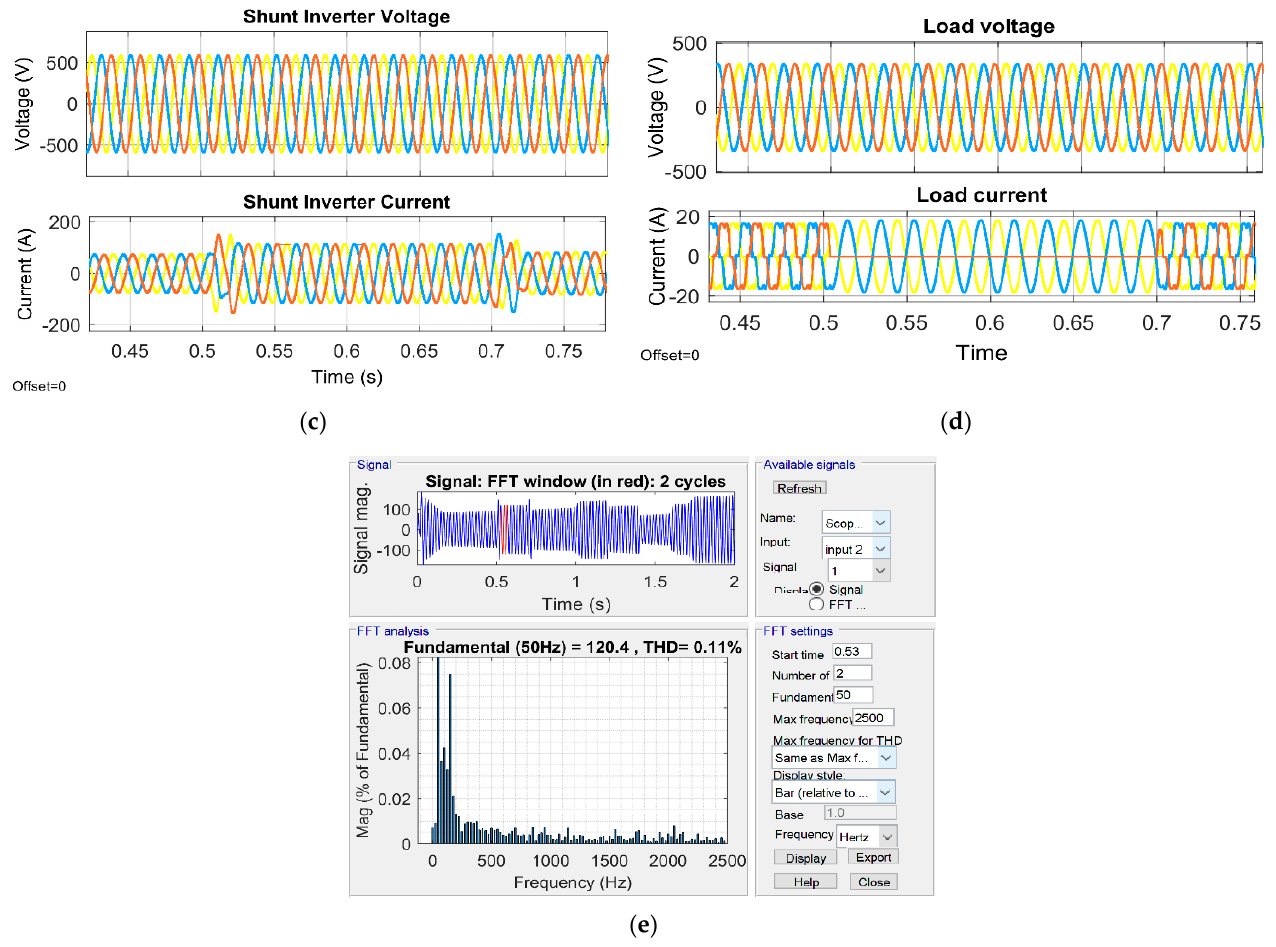
Figure 11. Response of the system parameters under unbalanced load conditions, ( a ) Battery voltage and current under unbalanced load conditions, ( b ) Grid voltage and current under unbalanced load conditions ( c ) Shunt inverter voltage and current under unbalanced load conditions, ( d ) Load voltage and current under unbalanced load conditions, ( e ) THD under unbalanced load conditions.